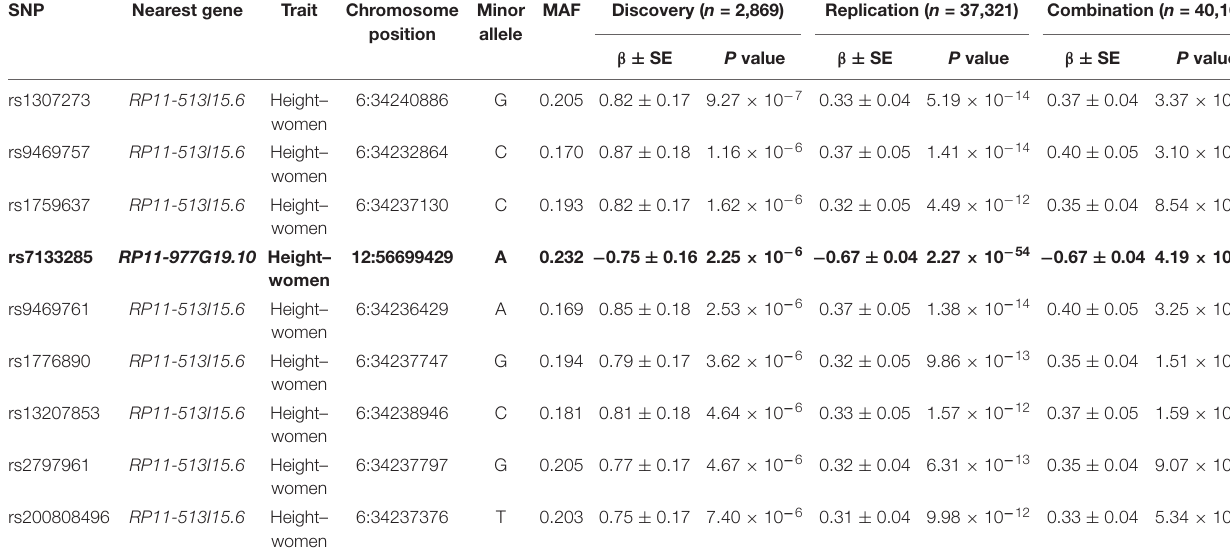
TABLE 2 | Identified novel variants with genome-wide significant associations. SNP Nearest gene Trait Chromosome